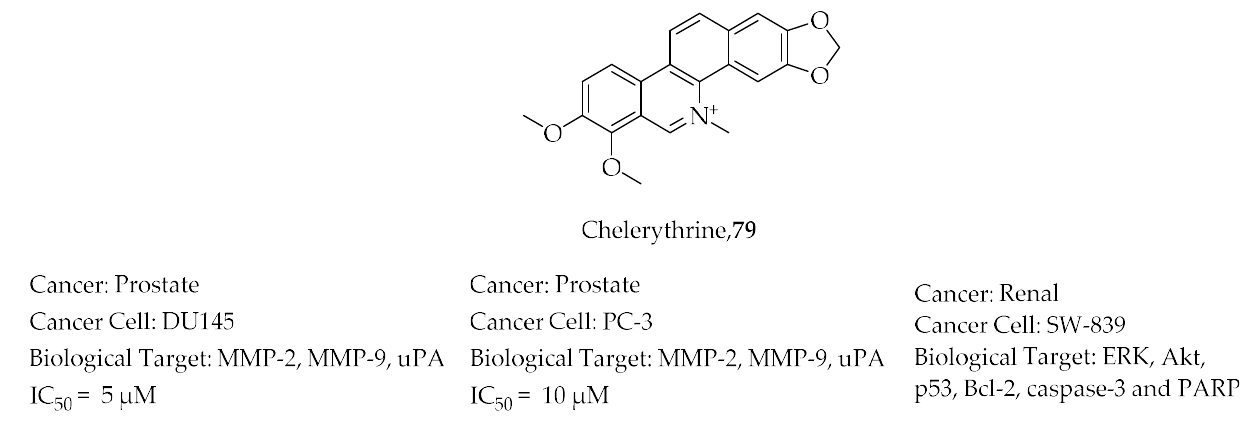
Figure 13. Chemical structure of Chelerythrine with a summary of its biological activity towards selected cancer targets.